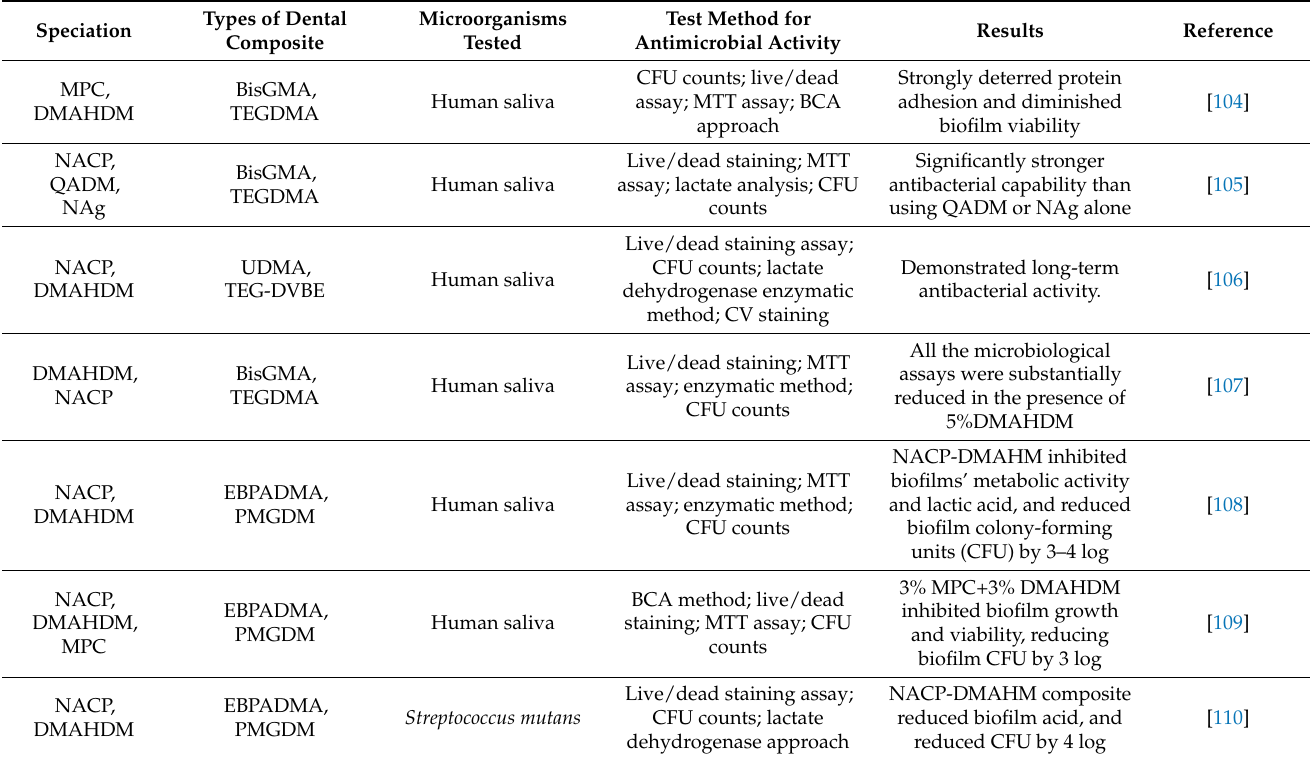
Table 2. Summary of synergistic antimicrobial